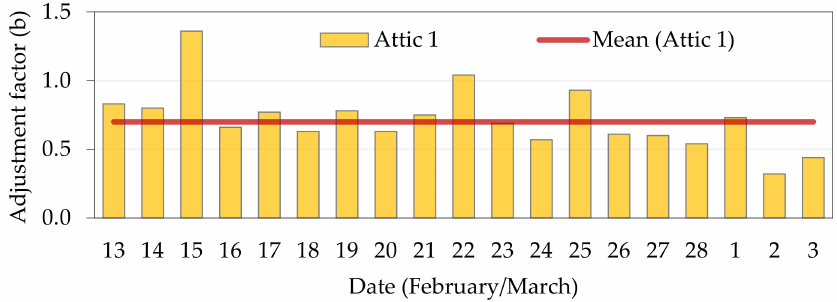
Figure 11. Daily variation of the adjustment factor (b) for Attic 1. Table 17. Values of the estimated adjustment factor (b) for Attic 1.